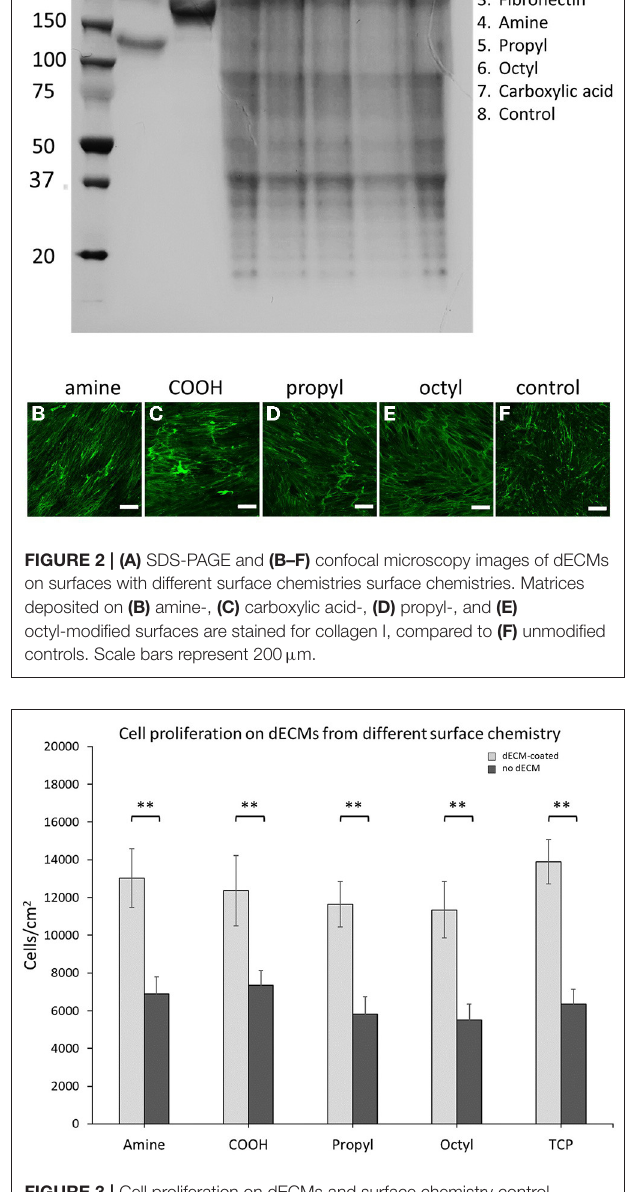
FIGURE 3 | Cell proliferation on dECMs and surface chemistry control surfaces. Brackets indicate significant differences, with ** < 0.01. All means were statistically compared using a two-way ANOVA and a Tukey’s post-hoc test. However, only differences between a dECM-coated surface and its surface chemistry control are indicated for clarity.